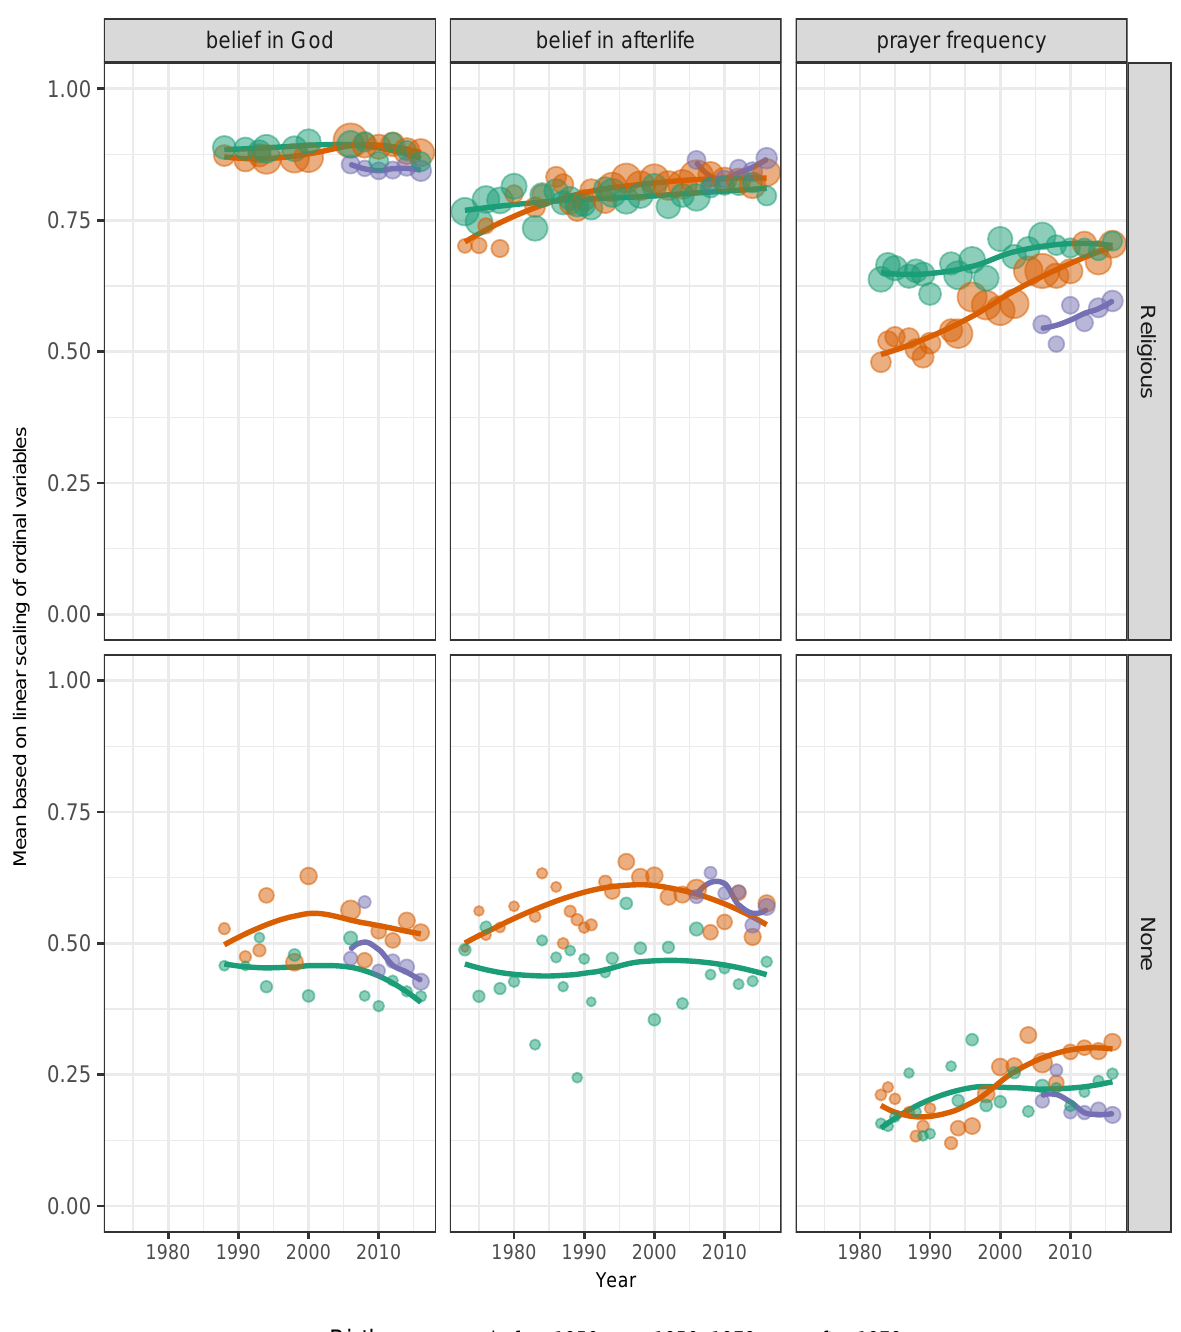
Figure 7: Trends in religious beliefs and practices disaggregated by affiliation status and birth cohort. All ordinal questions are treated as a linear quantitative scale with a maximum of one and a minimum of zero. All means are sample weighted. Smoothed trend lines are shown for each group. Point size is scaled by sample